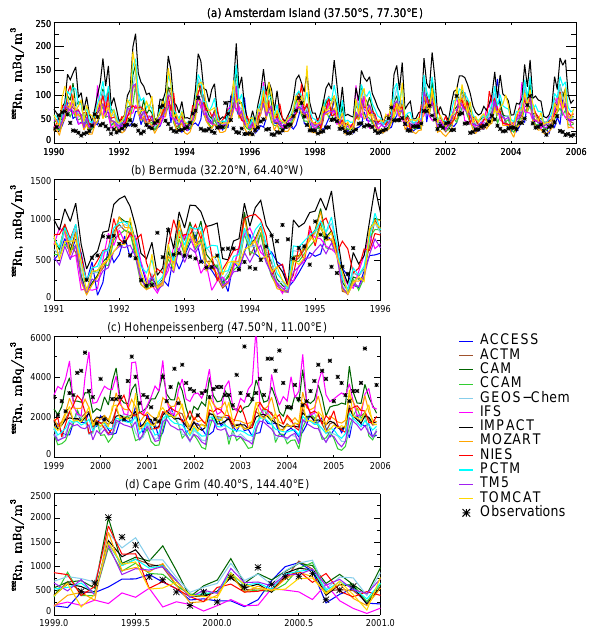
Fig. 9. Comparison of simulations and observations of near-surface 222 Rn concentration at (a) Amsterdam Island (37.5 ◦ S, 77.3 ◦ E), (b) Bermuda (32.2 ◦ N, 64.4 ◦ W), (c) Hohenpeissenberg (47.5 ◦ N, 11 ◦ E) and (d) Cape Grim (40.4 ◦ S, 144.4 ◦ E). The colored lines are the results of the different transport models; the black symbols are observations. Note that the scales of the x- and y-axes differ among the panels. Here we used results of low-resolution versions of IMPACT and TM5 models, as high-resolution data do not cover considered